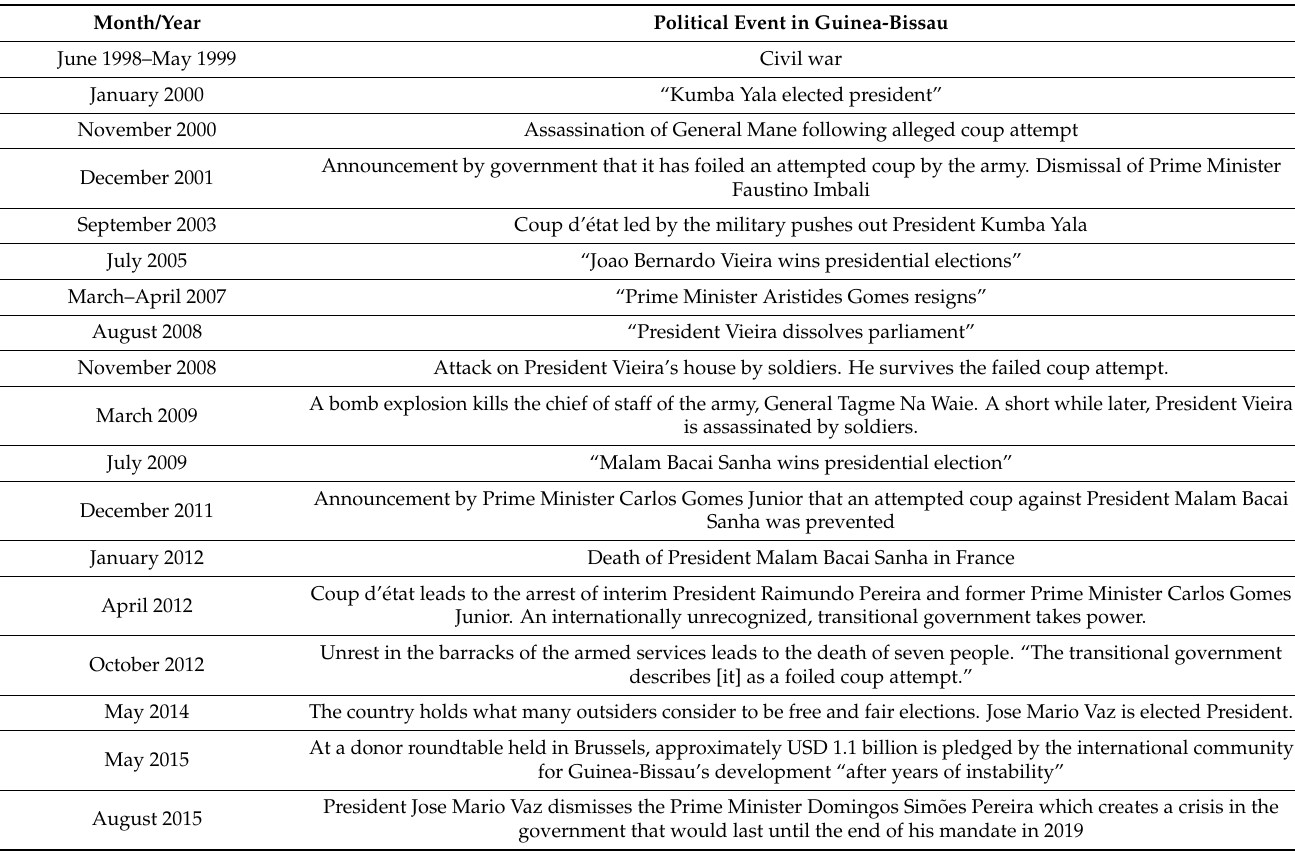
Table A2. Major milestones of political instability in Guinea-Bissau during the Millennium Development Goal (MDG)